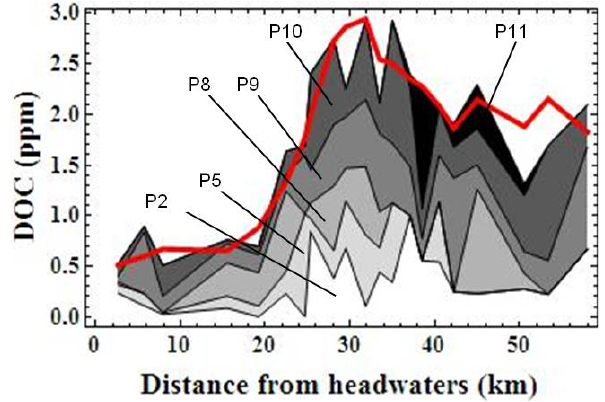
Fig. 9. Comparison of the observed DOC spatial dynamic (red line) with that modelled with six peaks (P2, P5, P8, P9, P10, P11) ac- cording the step-wise linear multiple linear regression ( r 2 = 0 . 969, d.f. = 14, p < 0.001). Different gray tonality depicts the contribu- tion of each